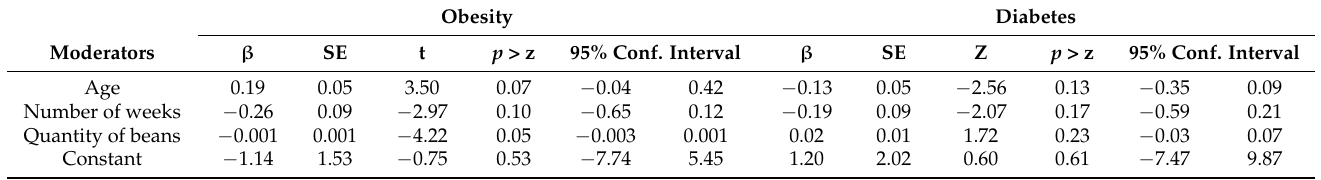
Table 2. Meta-regression with mean differences as dependent variables and the moderators as predictors. Obesity